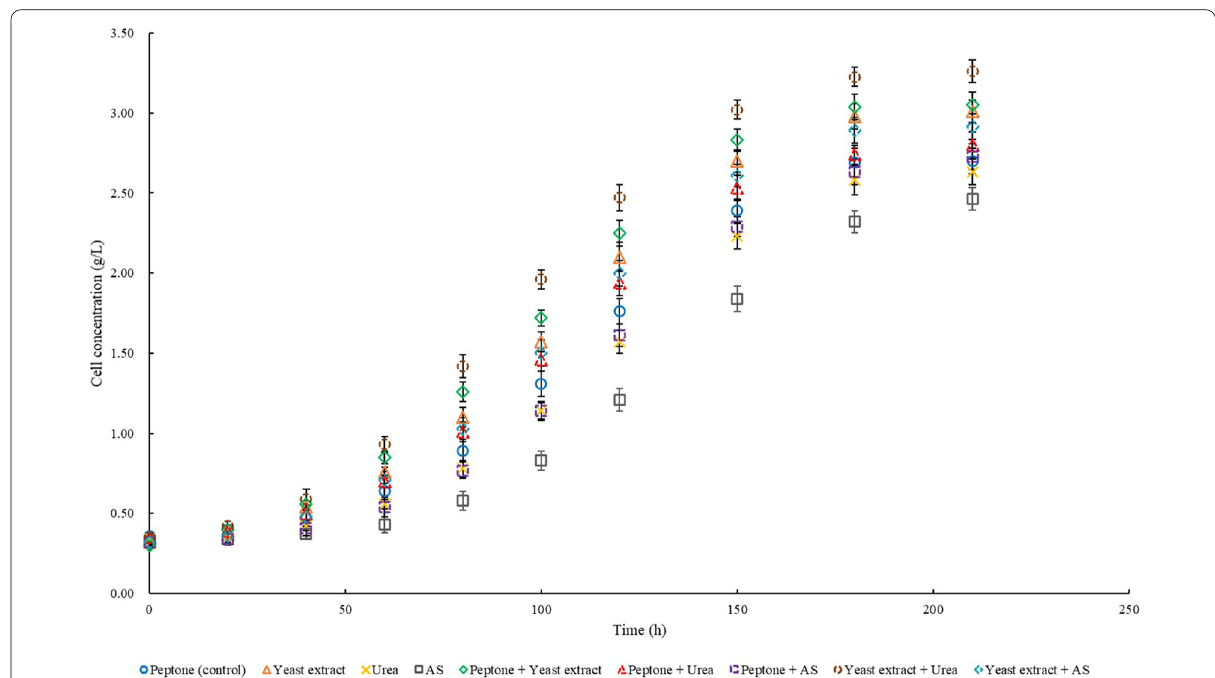
Fig. 5 Effects of different nitrogen sources on net cell